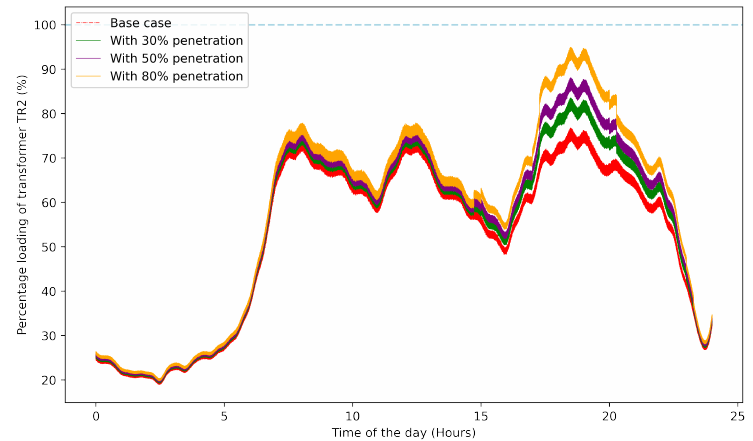
Figure 7. Percentage loading of transformer TR2 for different levels of EV penetration. The additional charging load from the EVs also impacts the node voltages during peak load periods as can be seen in Figure 8 for the case of 80% EV penetration.